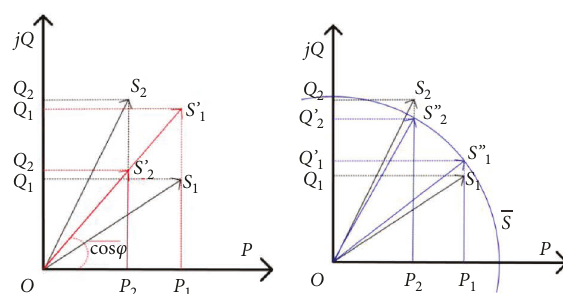
Figure 7: Reactive power adjustment under average angle and length of power. (a) Vector diagram of average angle. (b) Vector diagram of average